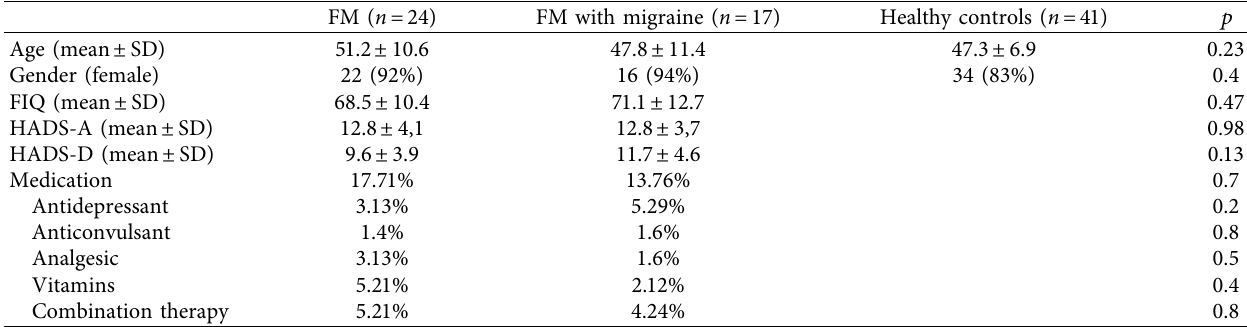
Table 1: Demographic and clinical features of the study population. FIQ, fibromyalgia impact questionnaire; HADS-A and HADS-D, Hospital Anxiety and Depression Scale. Variables are expressed as mean with standard deviation (SD) and numbers/count